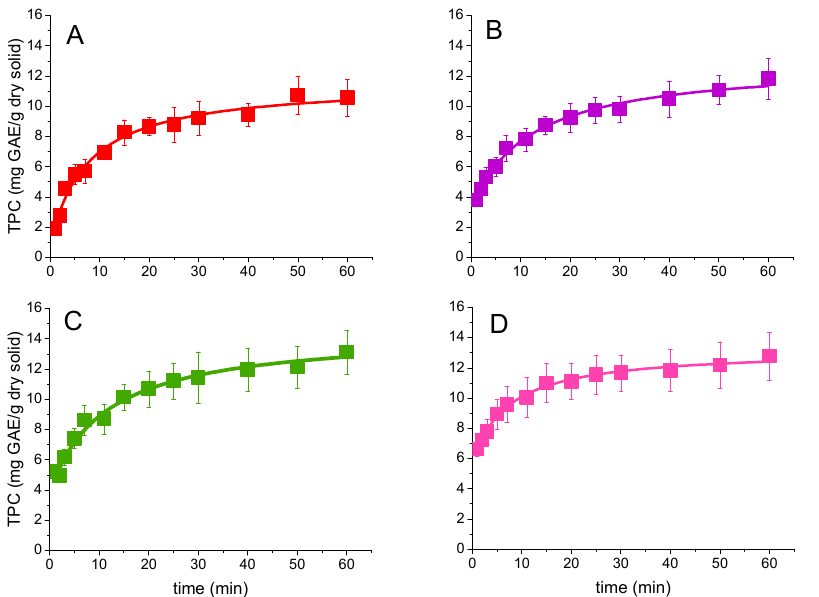
Figure 1. Results of total phenolic content (TPC) during extraction processes using AP and ethanol/water 70/30 (% v / v ) at different temperatures: ( A ) 25 ◦ C, ( B ) 50 ◦ C, ( C ) 70 ◦ C, and ( D ) 90 ◦ C. Data were obtained by the Folin–Ciocalteu method. Kinetic analysis corresponding to the second-order kinetic model is displayed as lines.